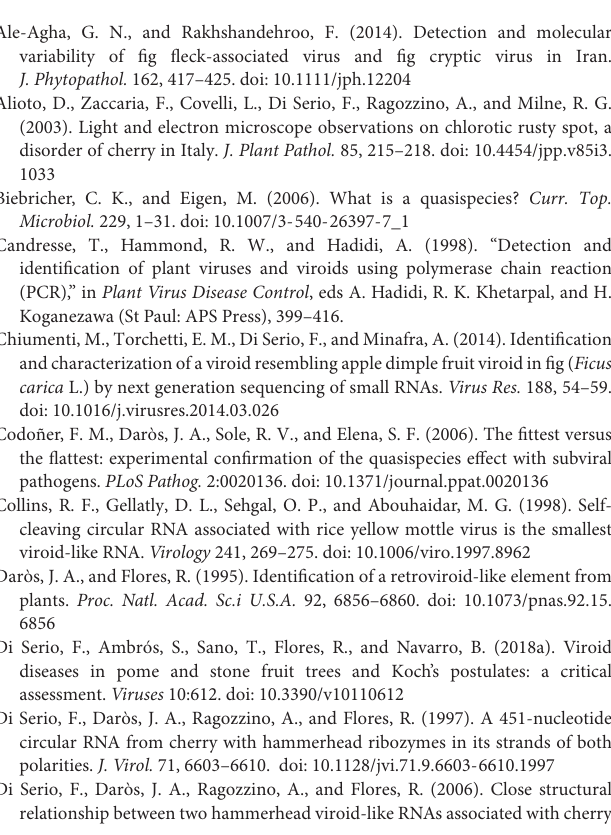
flags; arrows and bars indicate the self-cleavage sites and the nucleotides conserved in most natural hammerhead structures, respectively; filled (black) and open symbols refer to ( + ) and ( − ) polarity, respectively. FIGURE S3 | Pairwise comparison between the short viroid-like RNA (Vd-LRNA) from island of Kauai and FHVd-LR (master sequence) from the island of Oahu. The sequence identity is 96.1%. Positions with identical nucleotides are denoted by asterisks. FIGURE S4 | Northern blot hybridization with equalized full-length digoxigenine-labeled riboprobes for detecting FHVd-LR ( + ) or ( − ) strands (left and right panel, respectively). In each panel, lanes 1 and 2 correspond to equal amounts of dimeric FHVd-LR ( + ) and ( − ) transcripts, respectively. Positions of the FHVd-LR ( + ) and ( − ) linear monomeric forms (m) are indicated by an arrow. Position and size (in nt) of the RNAs used as molecular markers are reported on the left. FIGURE S5 | (A) Schematic representation of plasmids containing head-to-tail dimeric constructs of FHVd-LR and of the products generated by in vitro transcription. Plasmids containing the dimeric sequence of FHVd-LR in opposite orientations were linearized with Sal I or Nco I and transcribed with T7 or SP6 RNA polymerase, respectively. Transcription of these templates is expected to produce complete dimeric transcripts (D), fragments longer than a monomer (5 (cid:48) F-M and 3 (cid:48) F-M) generated by the self-cleavage of one hammerhead ribozyme (HRz), monomeric RNAs (M) and fragments (5 (cid:48) F and 3 (cid:48) F) generated by the self-cleavage of both HRzs. In green, plasmid sequences; in yellow, polymerase promoter; in blue, FHVd-LR sequence, with the arrows indicating the ( + ) orientation; arrowheads and scissors mark the positions of the self-cleavage sites. Numbers on the left of each RNA fragment indicate its expected size. (B) Analysis by PAGE of the in vitro transcription of plasmids containing ( + ) and ( − ) dimeric FHVd-LR cDNA; L1 and L2, RNA ladders with sizes indicated on the left and on the right, respectively; for other symbols see panel (A)